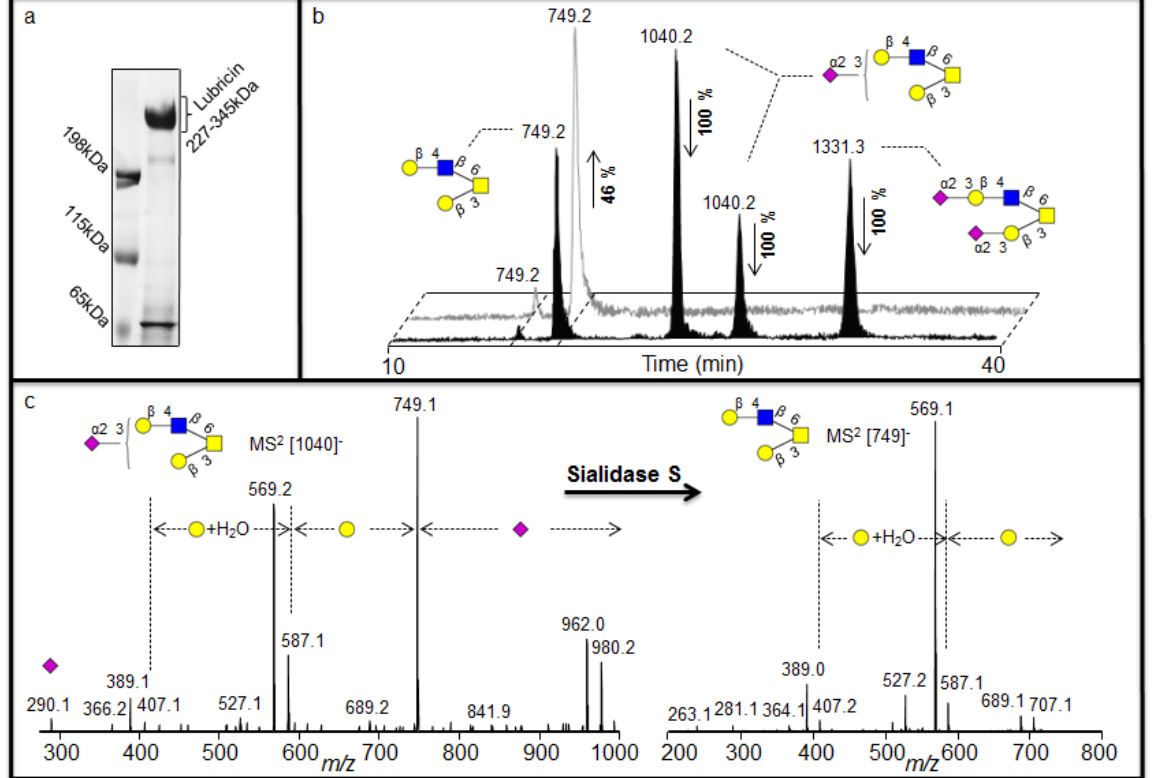
Figure 2. Negative ion LC-MS 2 analysis of sialylated structures in human synovial lubricin. (a) Enrichment of human synovial lubricin by SDS-PAGE. (b) Selected ion chromatogram (SIC) of the [M - H] - ions at m/z 749 , 1040 and 1331 before (front) and after the treatment (back) with sialidase S confirming the α 2-3 linked sialic acid configuration of oligosaccharide. Percentage shows the increase or decrease of the structures due to treatment. (c) MS 2 spectrum of the [M - H] - ions at m/z 1040 with α 2-3 linked sialic acid before treatment and MS 2 spectrum of the [M - H] - ions at m/z 749 increased after the treatment. For explanation of symbols, see legend in Table